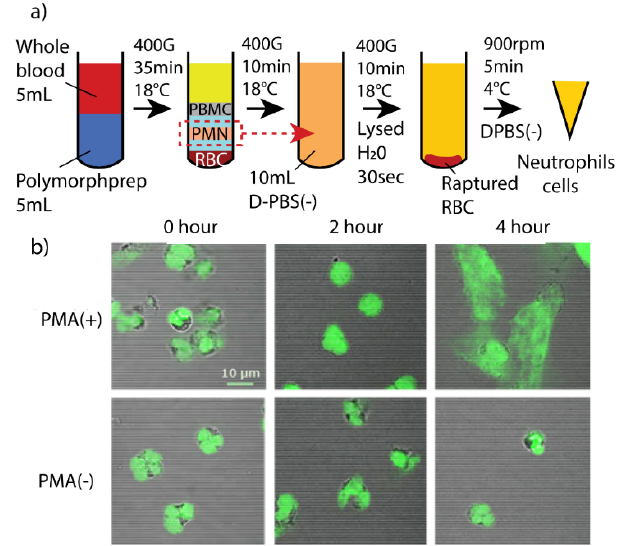
Figure 6. Phorbol 12-myristate 13-acetate (PMA) solution-induced neutrophils cells: ( a ) Preparation of neutrophils from human red blood cells; ( b ) the fibril releases from neutrophils cells under stimulation of PMA and D-PBS(–) solutions; denoted as PMA(+) and PMA(–), respectively.